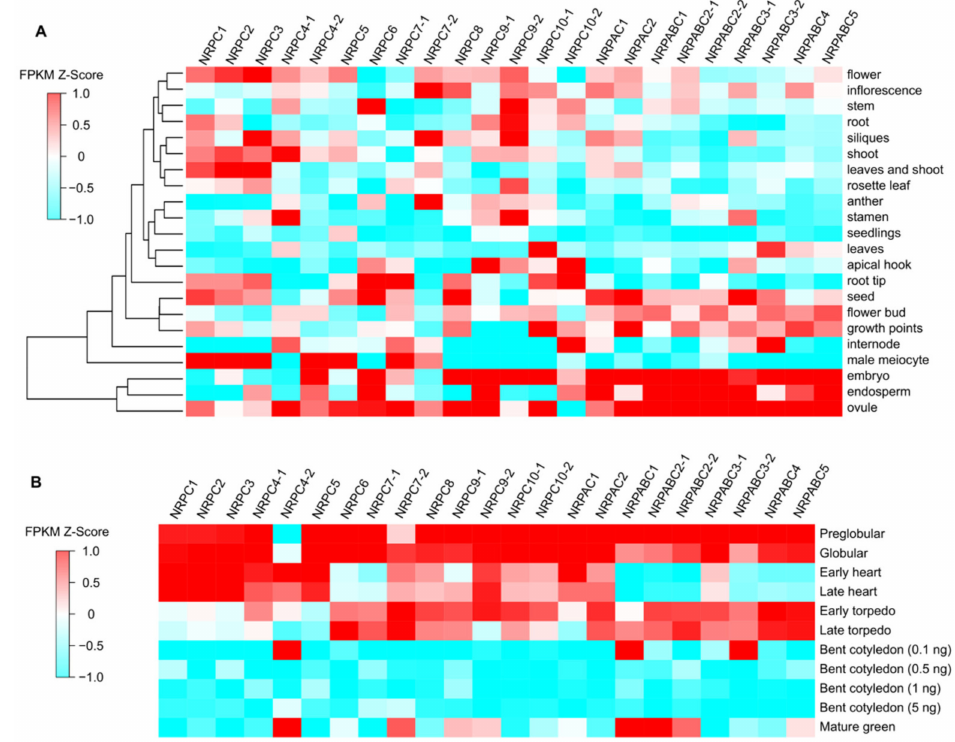
Figure 1. Expression patterns of RNAPIII subunits in Arabidopsis. ( A ) Expression patterns in different tissues and organs. ( B ) Expression patterns in seeds at different stages of